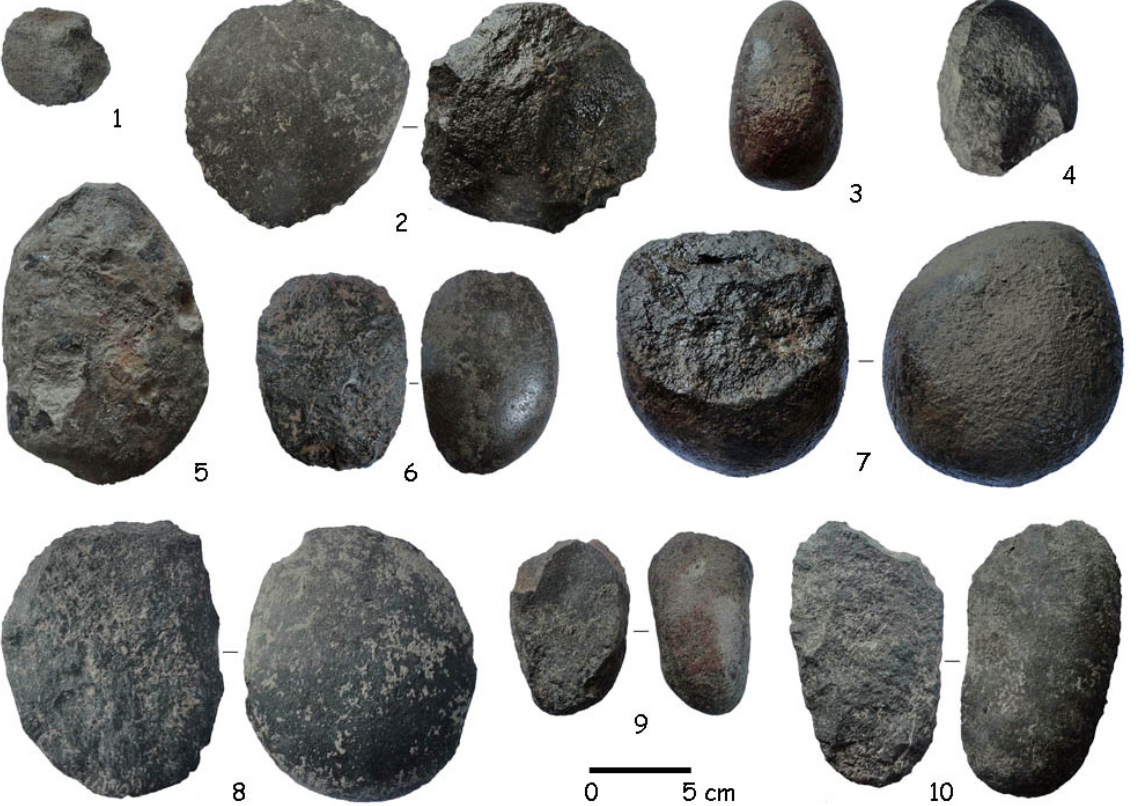
Figure 15. Diversité d’un assemblage hoabinhien, Laang Spean, Cambodge ( split , non split ). 1-7 : non split ; 8- 10 : split . Figure 15. Diversity of hoabinhian assemblage, Laang Spean (Cambodia) ( split, no split ). 1-7: no split ; 8-10: split